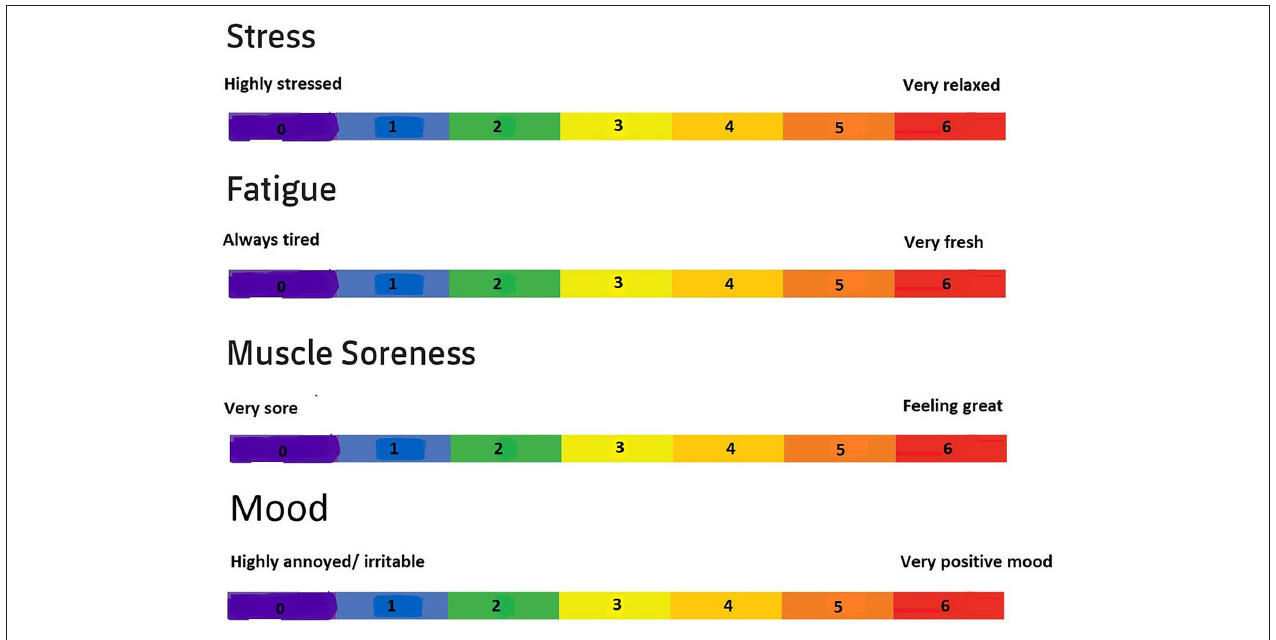
FIGURE 1 | Modified Hooper